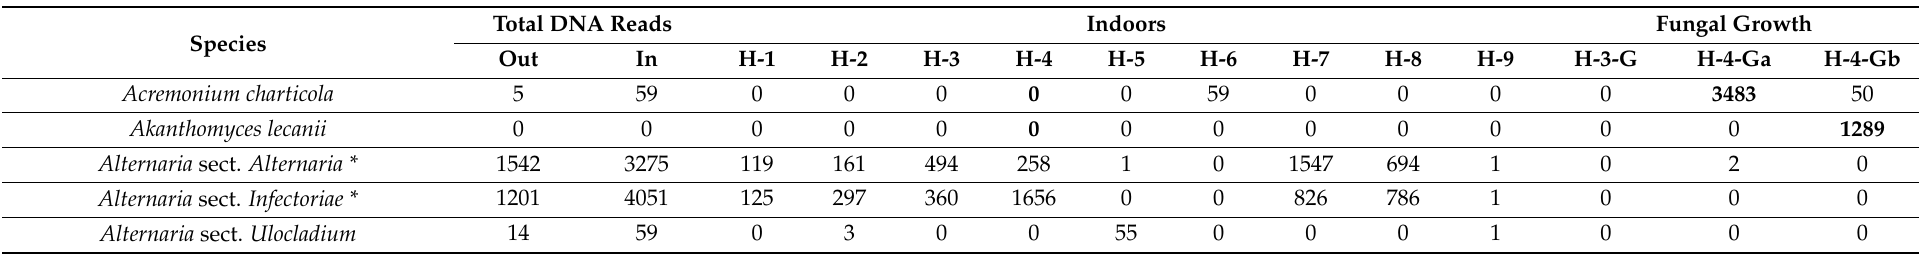
Table 3. Culture-independent identification. The most abundant indoor fungal species at the nine homes (H) and the total reads for the different OTUs out and in. Samples from the interior doorframe and on three samples from painted brick wall with visible fungal growth (G). High occurrences on the building materials compared to the corresponding dust sample are in